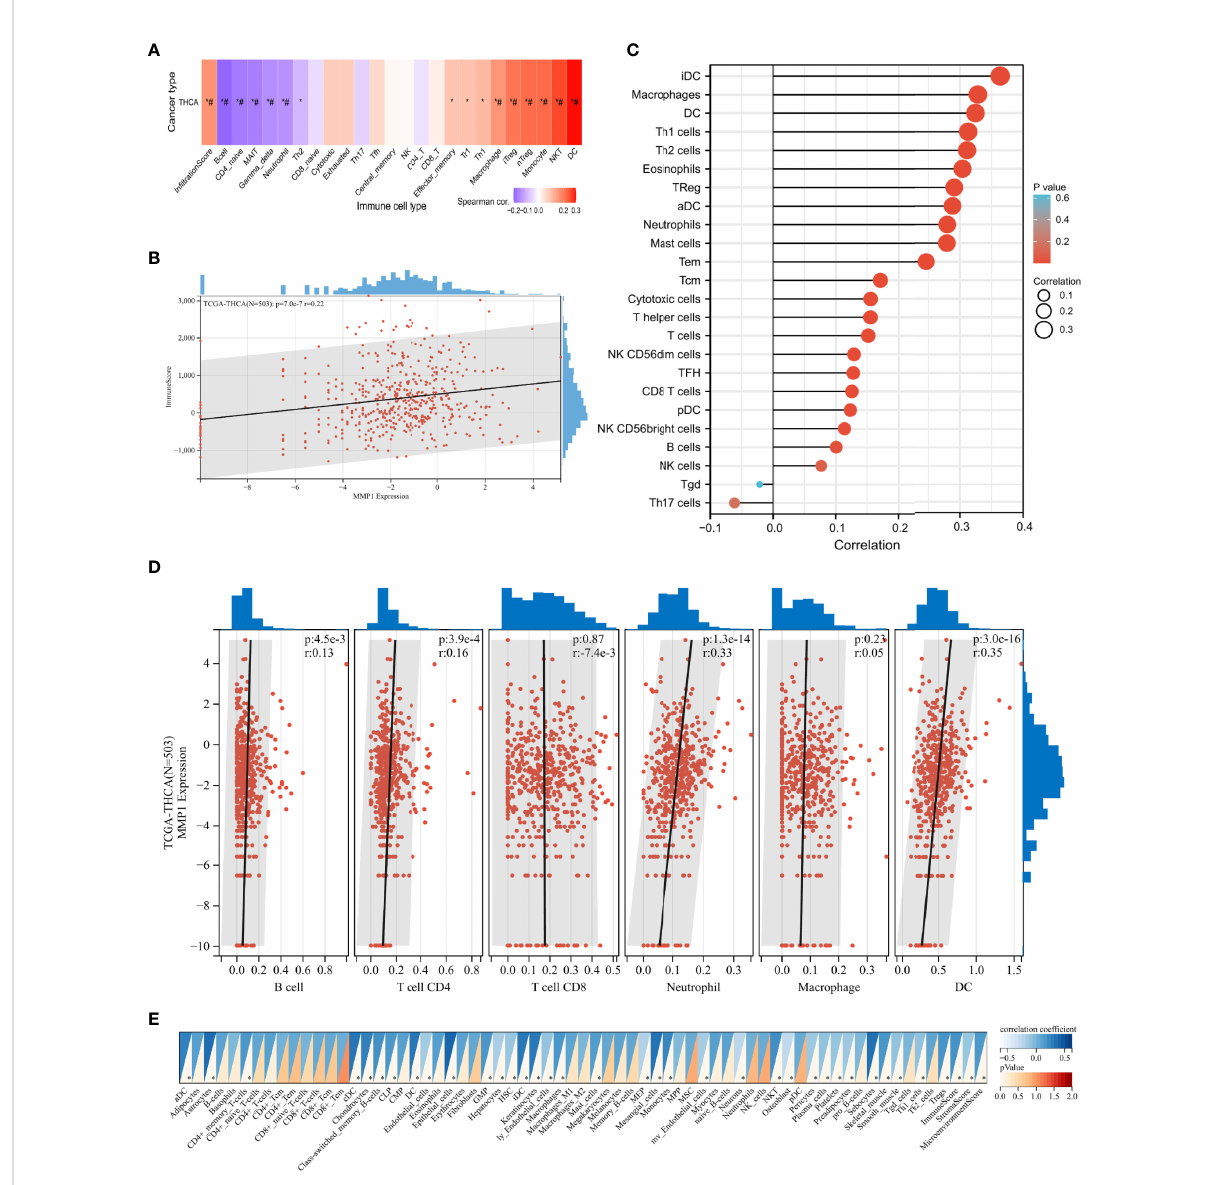
FIGURE 5 Correlation analysis of the expression of MMP1 with complex immune in fi ltration level in PTC samples from TCGA. (A) The correlation-heatmap between the GSVA scores and immune cell in fi ltrates over the PTC samples; (B) Correlation scatters plot of MMP1 levels and ImmuneScore of PTC samples. Different analyses of the correlation between MMP1 levels and immune in fi ltration: ssGSEA (C) , TIMER (D) , and xCELL (E) . PTC, papillary thyroid cancer; THCA, thyroid cancer. TCGA, The Cancer Genome Atlas; *P <0.05. # false discovery rate